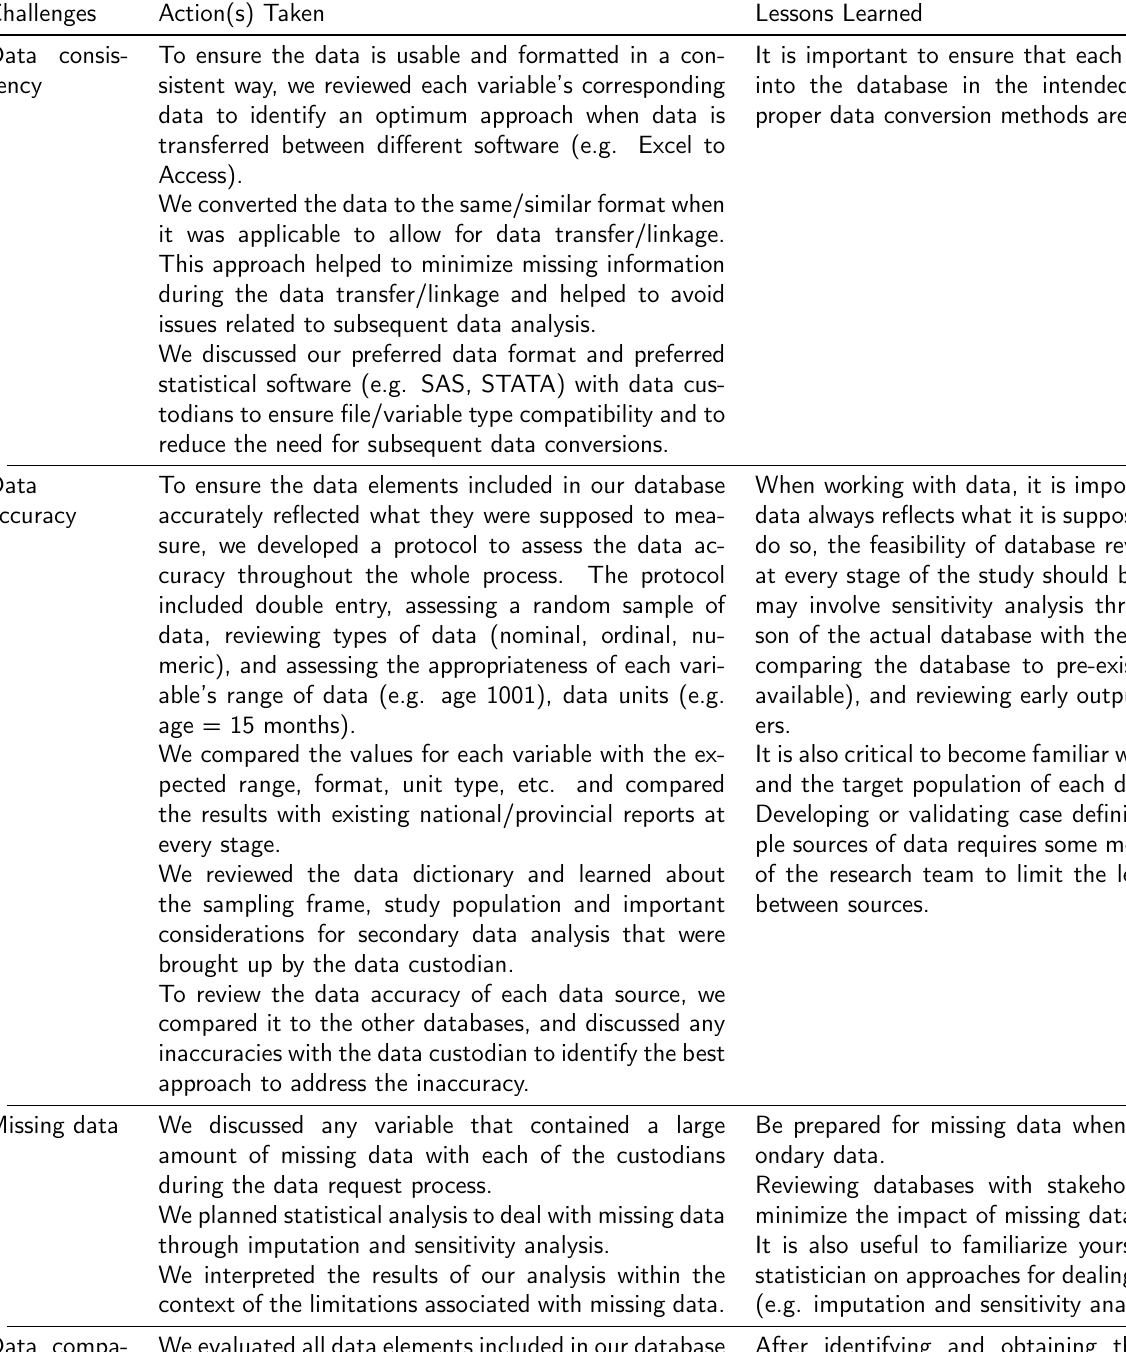
Table 2c: Action(s) taken and lessons learned for challenges that have a potential risk to data quality.